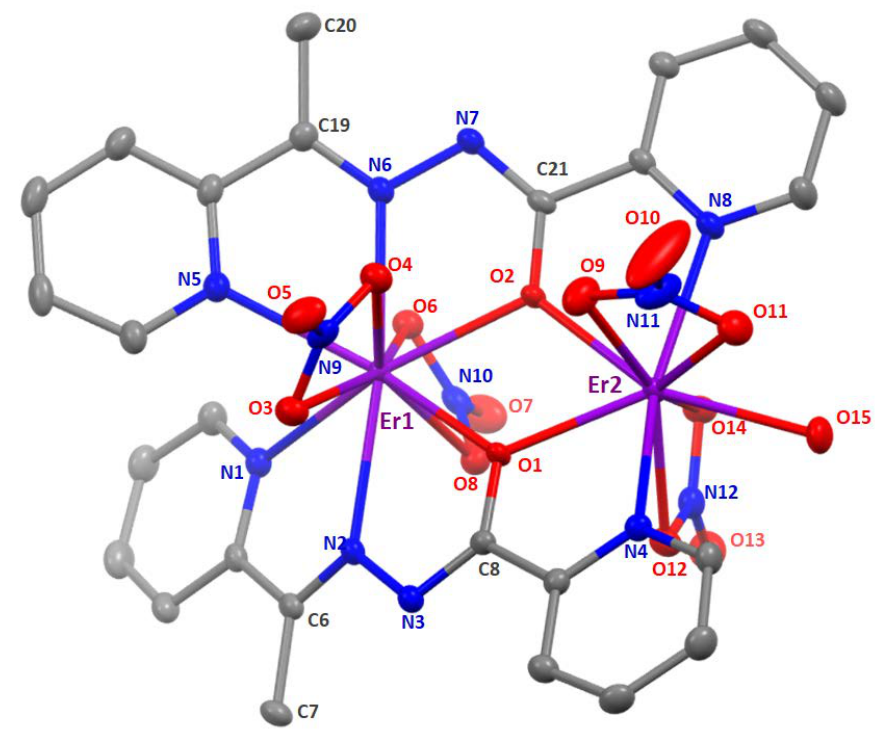
Figure 4. Molecular structure of [Dy 2 (NO 3 ) 4 ( L ) 2 (MeOH)] as found in 3 ∙2.5MeOH at 120 K. Thermal ellipsoids are depicted at 50% probability level. Hydrogen atoms are omitted for clarity. Note that only the major complex is depicted here, i.e., with coordinated MeOH instead of H 2 O, C1M having an occupancy of ca. 0.7.